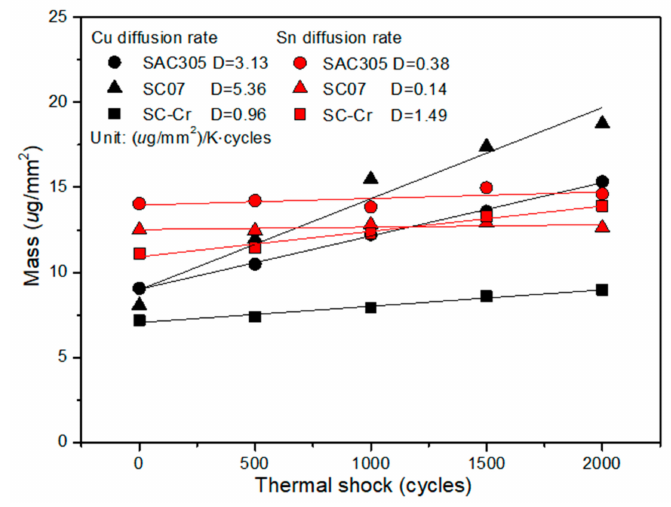
Figure 5. Plot of diffusivities of Cu and Sn versus thermal shock